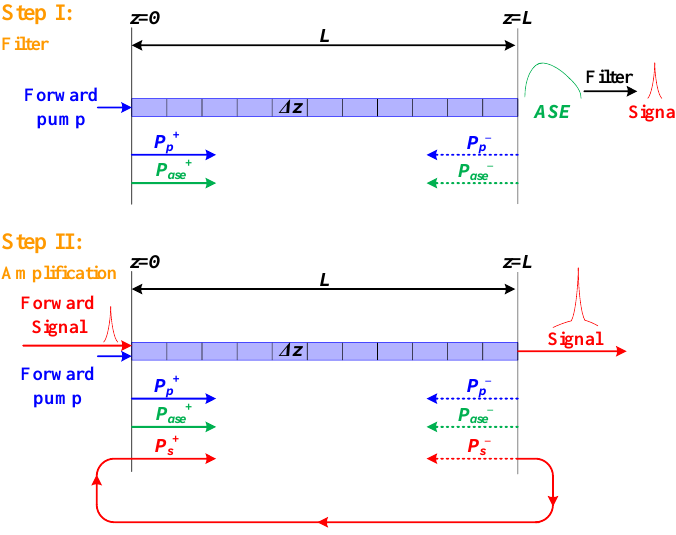
Figure 2. Calculation process. ASE, amplified spontaneous emission.